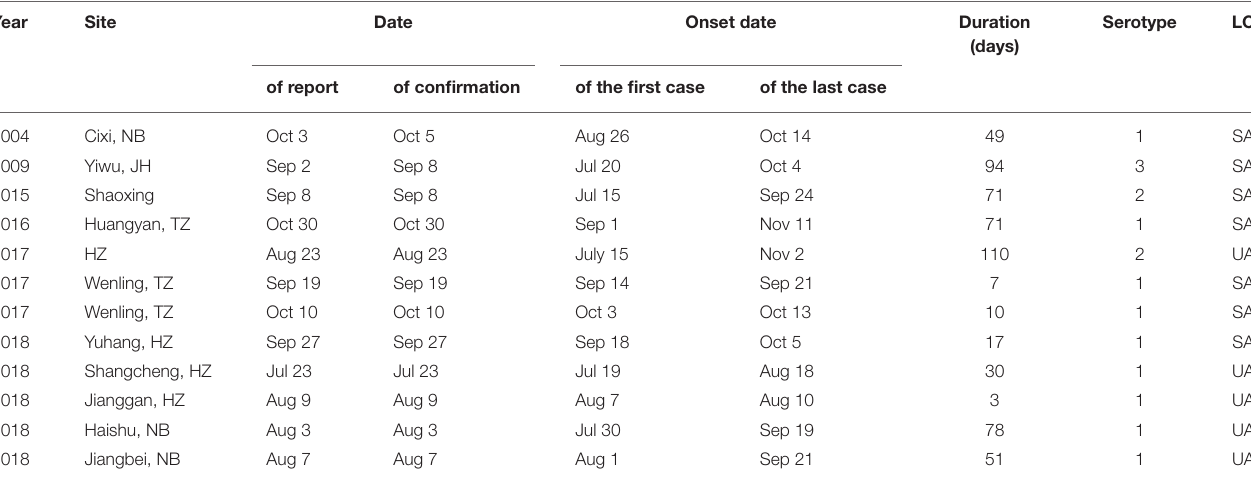
TABLE 2 | Characteristics of Dengue outbreaks in Zhejiang Province from 2004 to